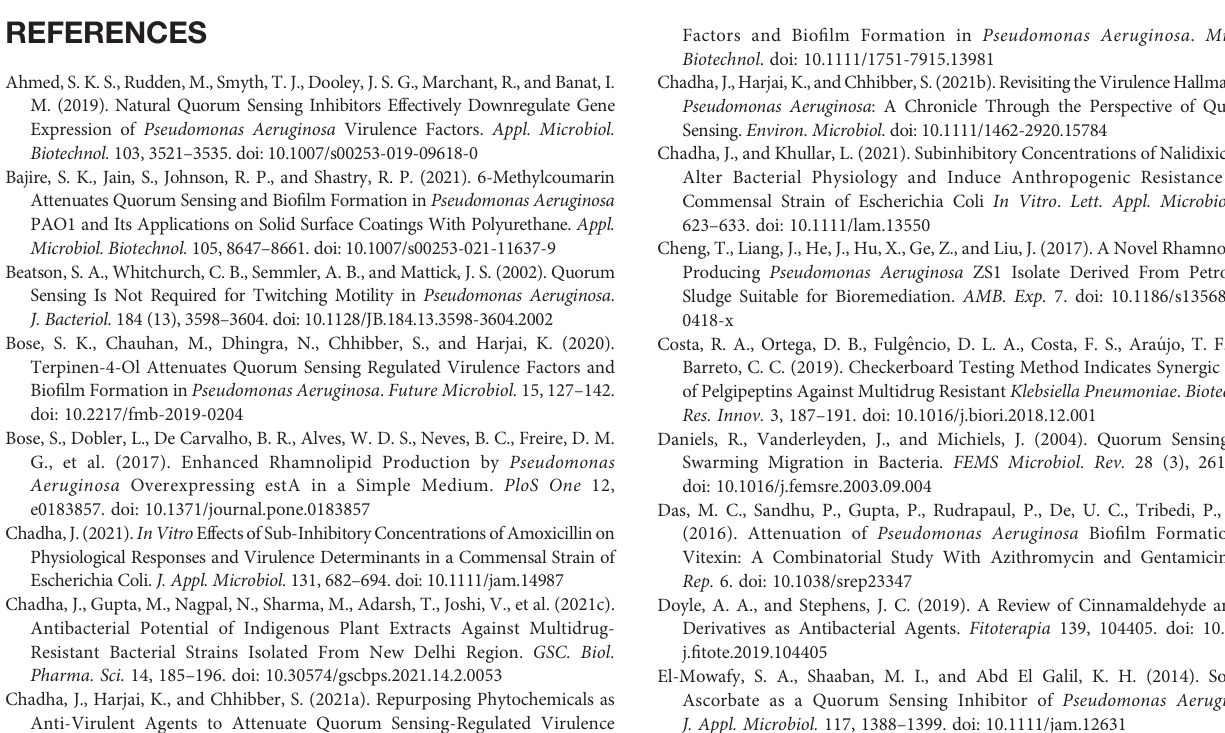
Supplementary Figure 1 | Resazurin dye reduction assay for determining the MICs of CiNN and GeN against P. aeruginosa PAO1. Supplementary Figure 2 | Molecular docking analysis predicting the probable interactions between CiNN and various QS receptors of P. aeruginosa using AutoDock Vina (Version 1.2.0). Supplementary Figure 3 | Molecular docking analysis predicting the probable interactions between Furanone C 30 (control) and various QS receptors of P. aeruginosa using AutoDock Vina (Version